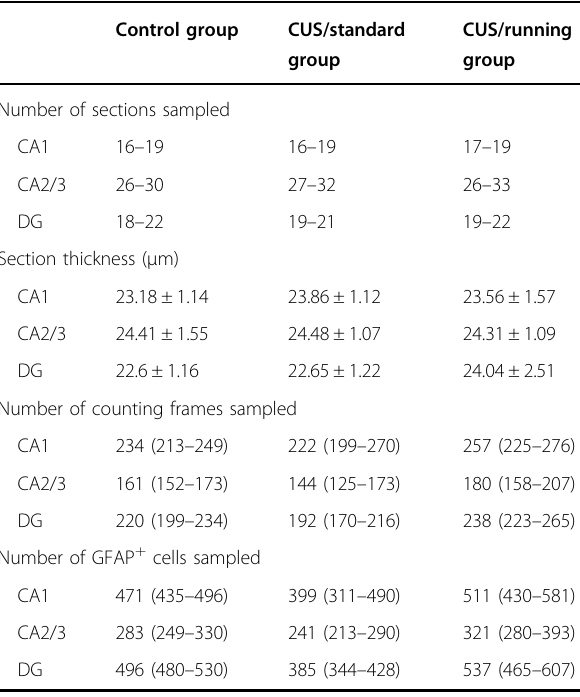
Table 3 Sampling scheme for the estimation of BrdU + , GFAP + , and BrdU + /GFAP +